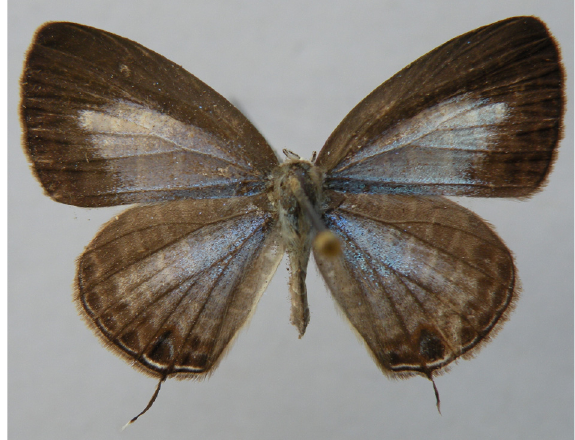
Image 4. Spangled Plushblue Flos asoka